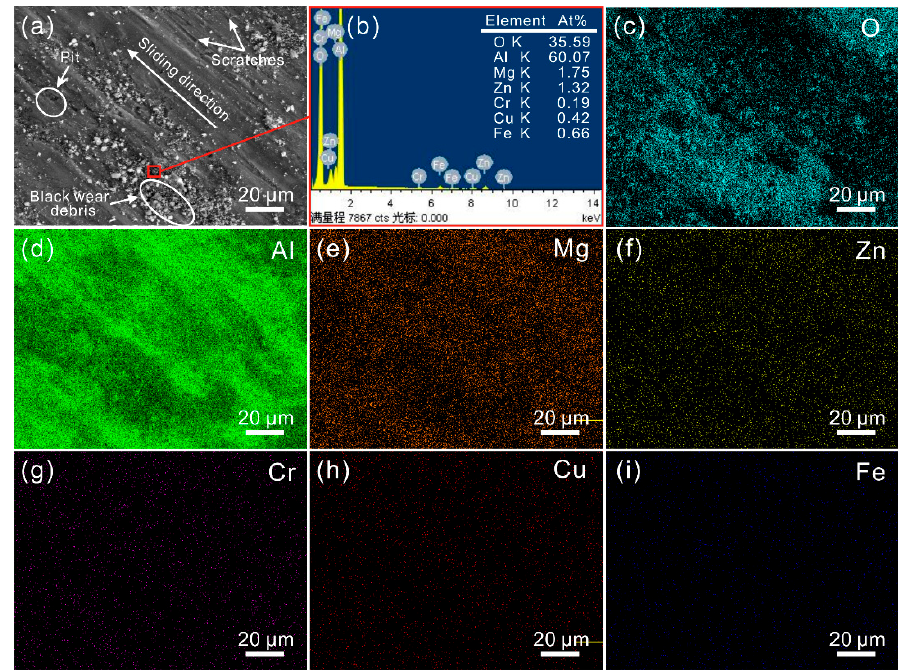
Figure 7. ( a ) SEM image of the worn surface of untreated surface sample; ( b ) EDS spectra of black wear debris; ( c ) – ( i ) element distribution of the worn surface (load of 0.3 N, sliding speed of 100 mm/s, frictional pair of GCr15 bearing steel).